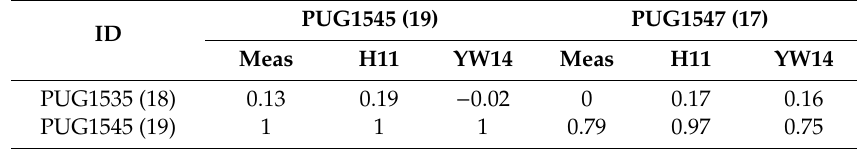
Table A3. Like Table A2 for southern Puget Sound.